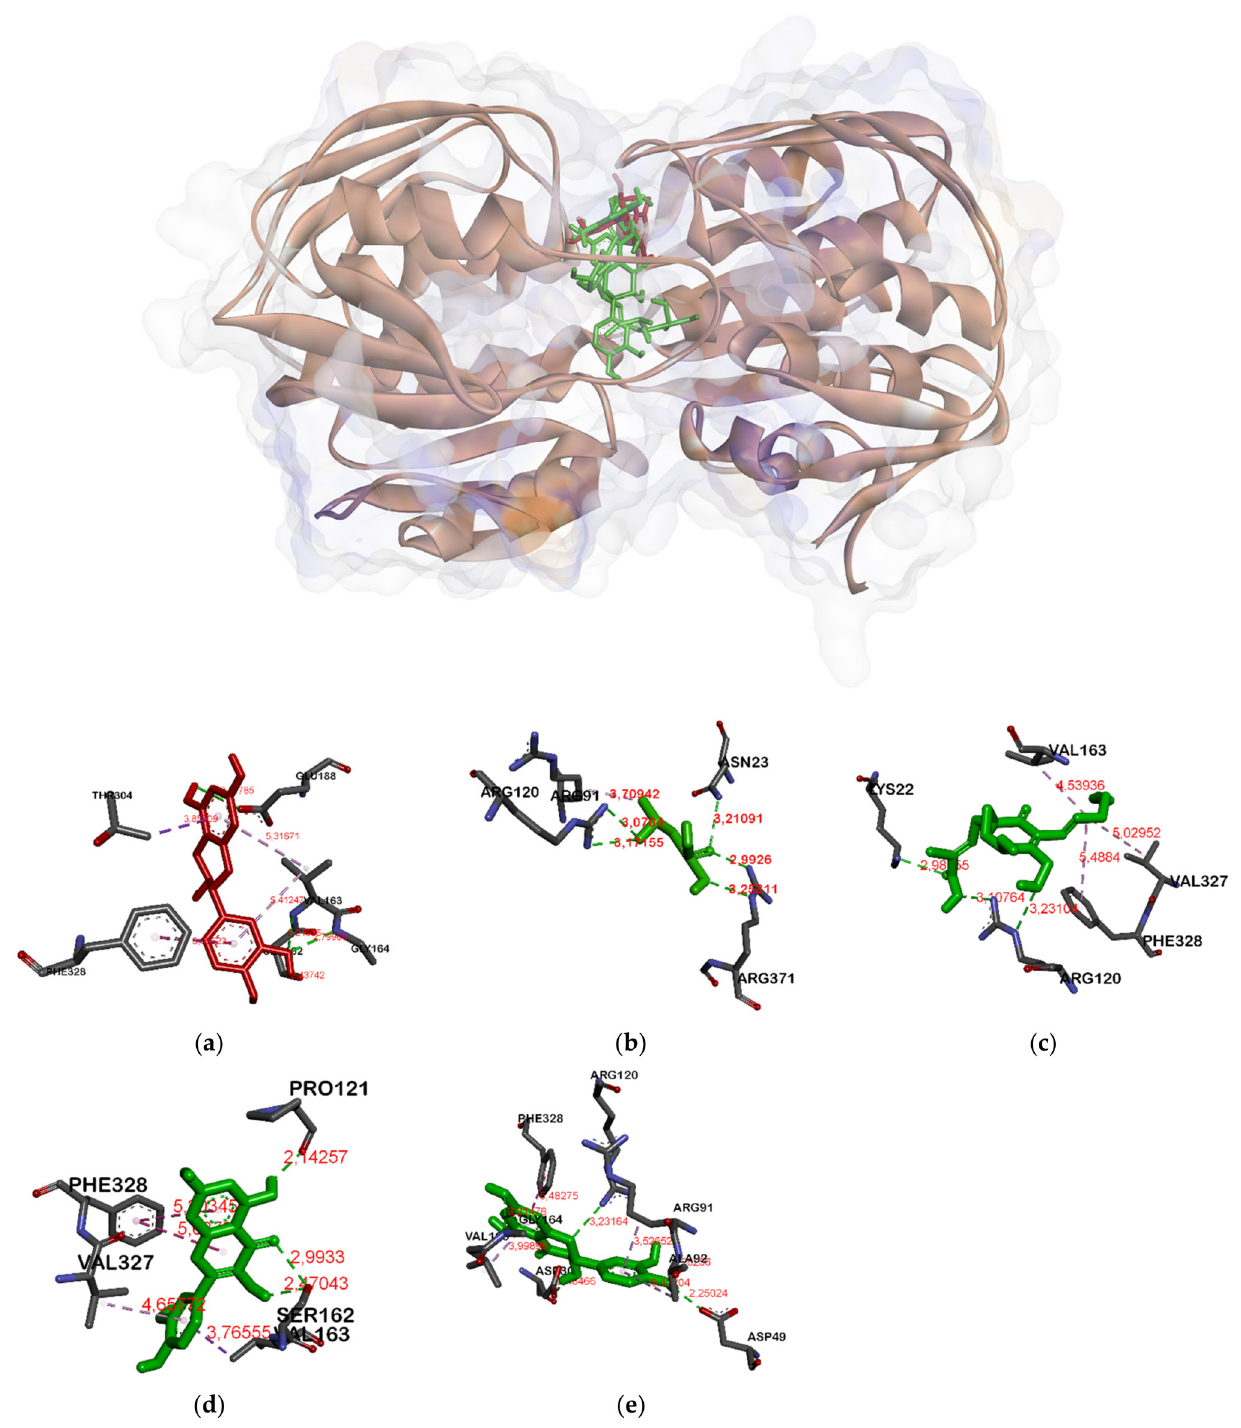
Figure 1. Binding site on MurA for catechin ( a ), fosfomycin ( b ), ambuic acid ( c ), quercetin ( d ) and taxifolin ( e